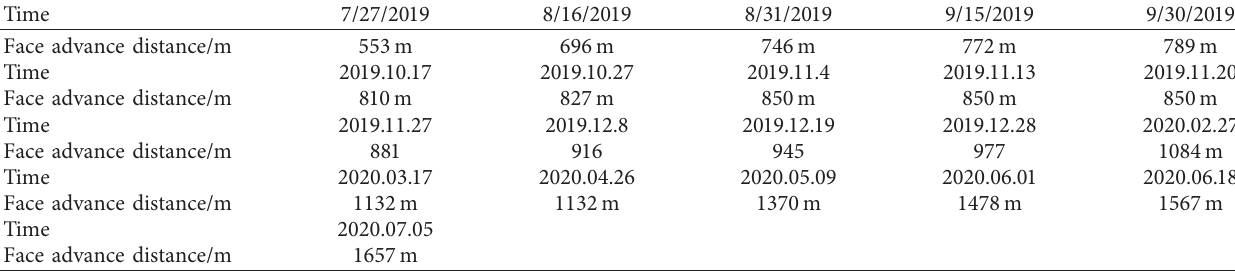
Table 4: Monitoring time for Line A and the corresponding working face advance distances.